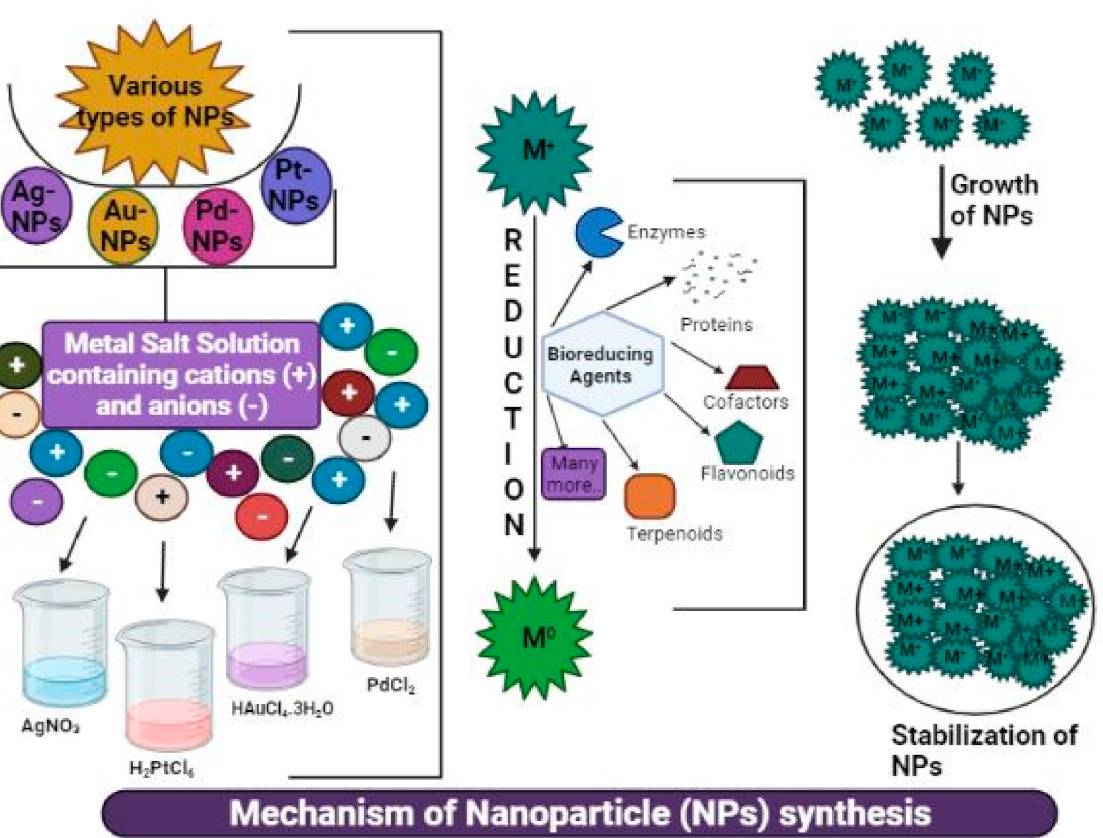
Figure 2. The synthesis of nanoparticles is shown through bio-reduction method. Metal is being reduced by metal salt solution (M + → M 0 ) to yield NPs with the help of various bio-reducing agents (enzymes, proteins, cofactors, flavonoids, terpenoids,